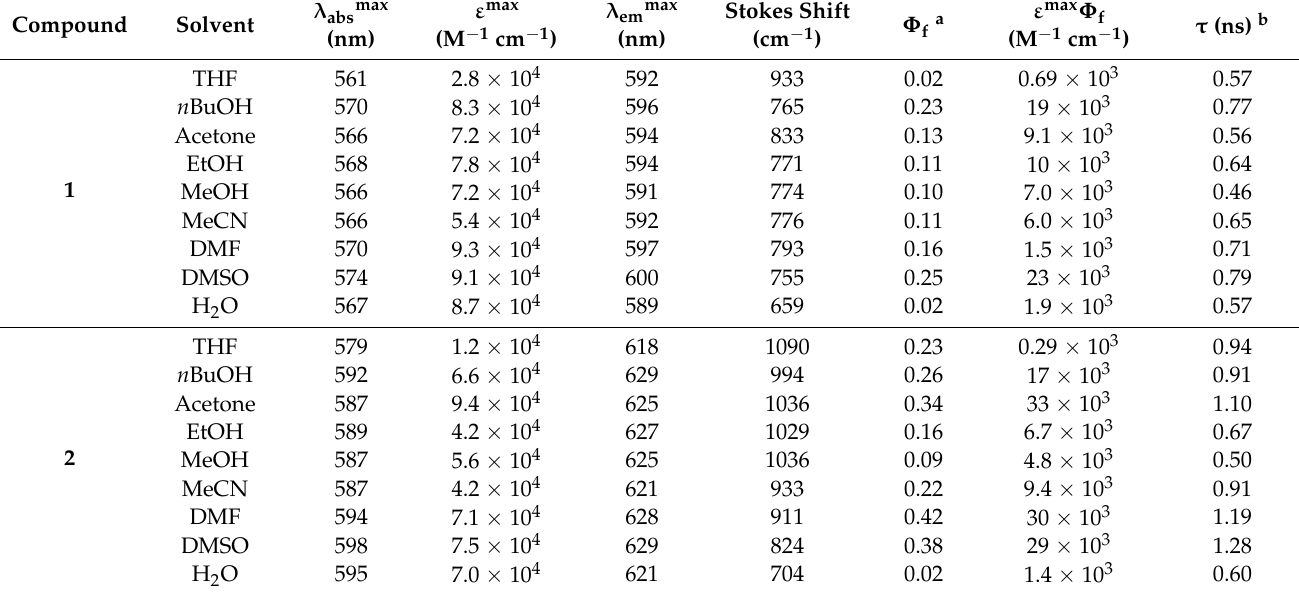
Table 1. Photophysical properties of fluorophores 1 and 2 in a series of medium to high-polarity solvents. Compound